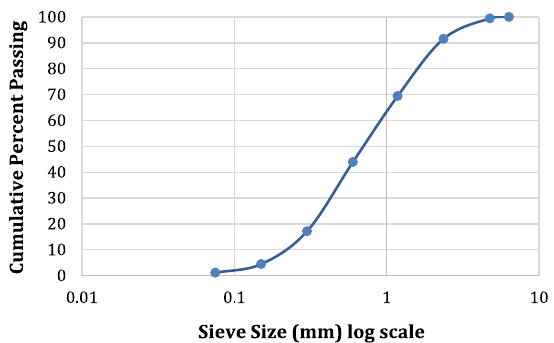
Fig. 3 Fine aggregates sieve analysis according to [41]